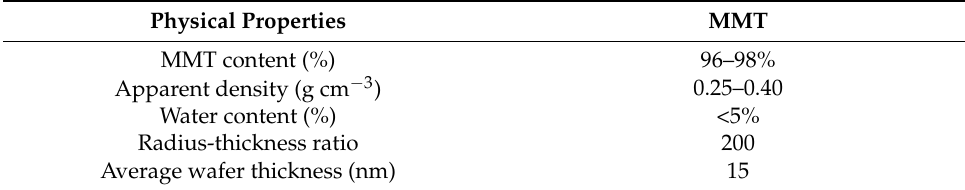
Table 2. Physical properties of